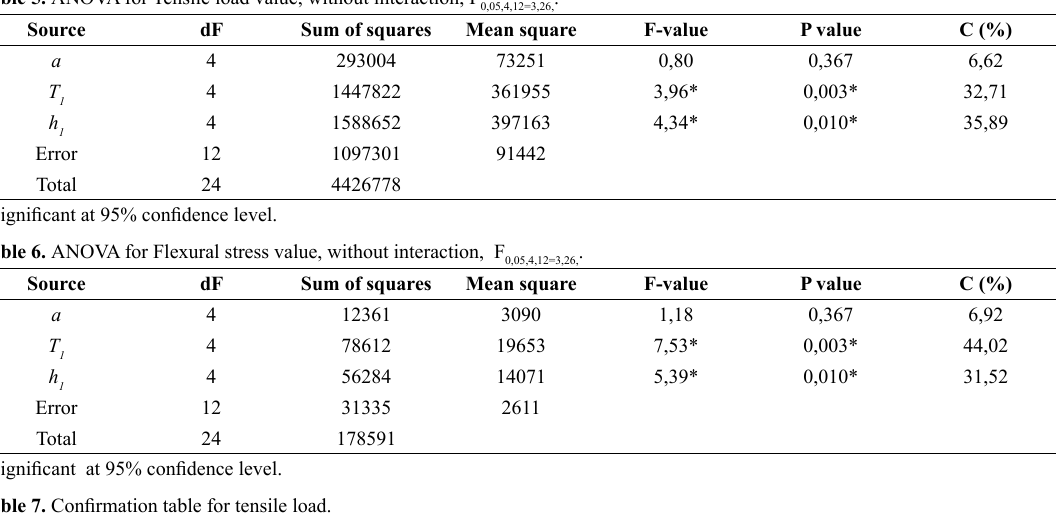
Table 5. ANOVA for Tensile load value, without interaction, F